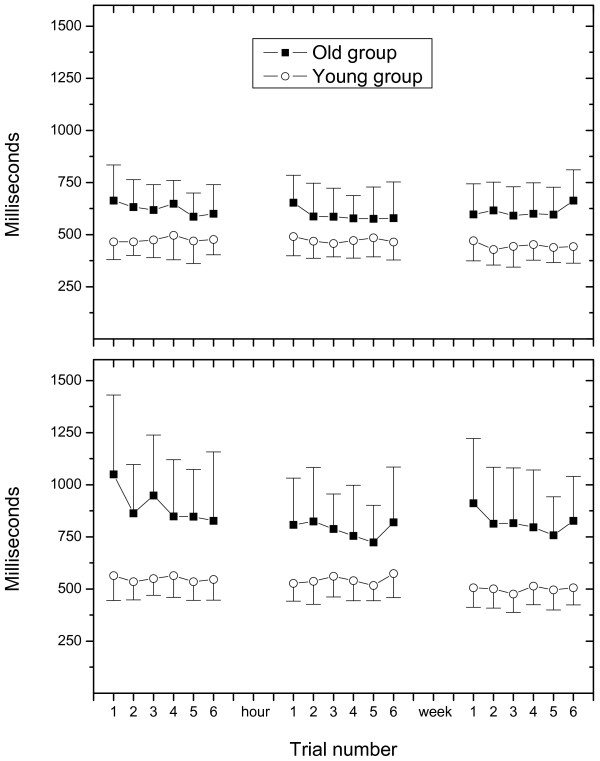
Foot-off times from the 1st, 2nd (an hour later) and 3rd (a week later) test session for the elderly and younger group of subjects, respectively, across 6 trials and Task conditions: single task condition (top) and dual task condition (bottom). Values represent mean foot-off times of elderly (filled square) and young (open circle) subjects. Vertical bars indicate one standard deviation. Notice decrease in foot-off times during the first test session for the elderly subjects, especially between the first and second trial under dual task conditions. A similar decrease is seen under dual task conditions for the third test session. Such effects were not present in the younger group.